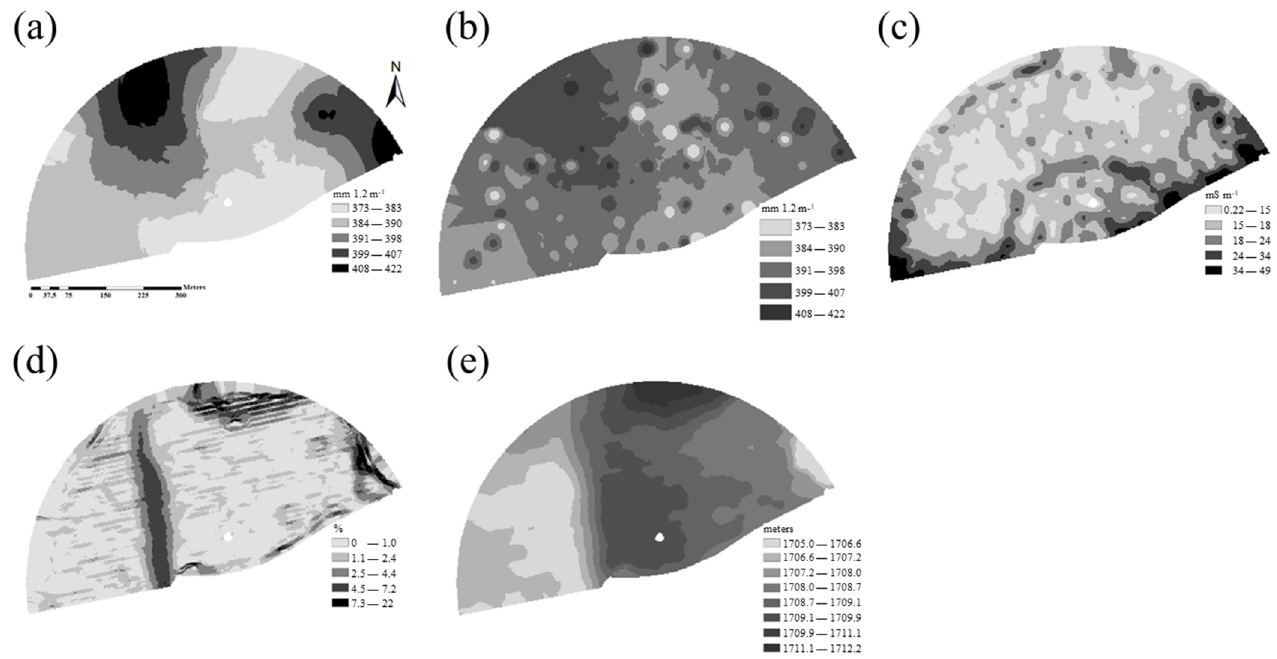
Figure 2. Interpolated maps of variables commonly used to delineate variable-rate irrigation zones ( a ) measured depth of soil water at field capacity in 0–1.2 m soil profile ( b ) measured depth of soil water holding capacity in 0–1.2 m soil profile ( c ) apparent electrical conductivity for the 0–0.90 m soil depth ( d ) slope ( e ) elevation.